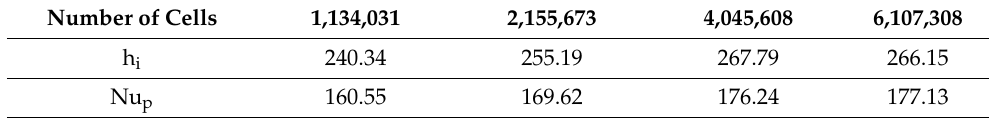
Table 5. Grid Sensitivity over Reynolds number of 18,000 for 20° inclination and 50 mm pitch.